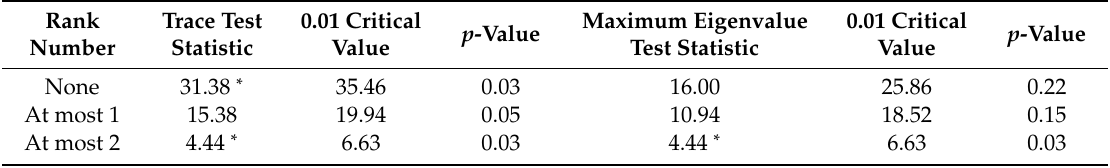
Table 3. Results of the Johansen cointegration test for CNY ( E1 t ,PL t , PJ t ) .